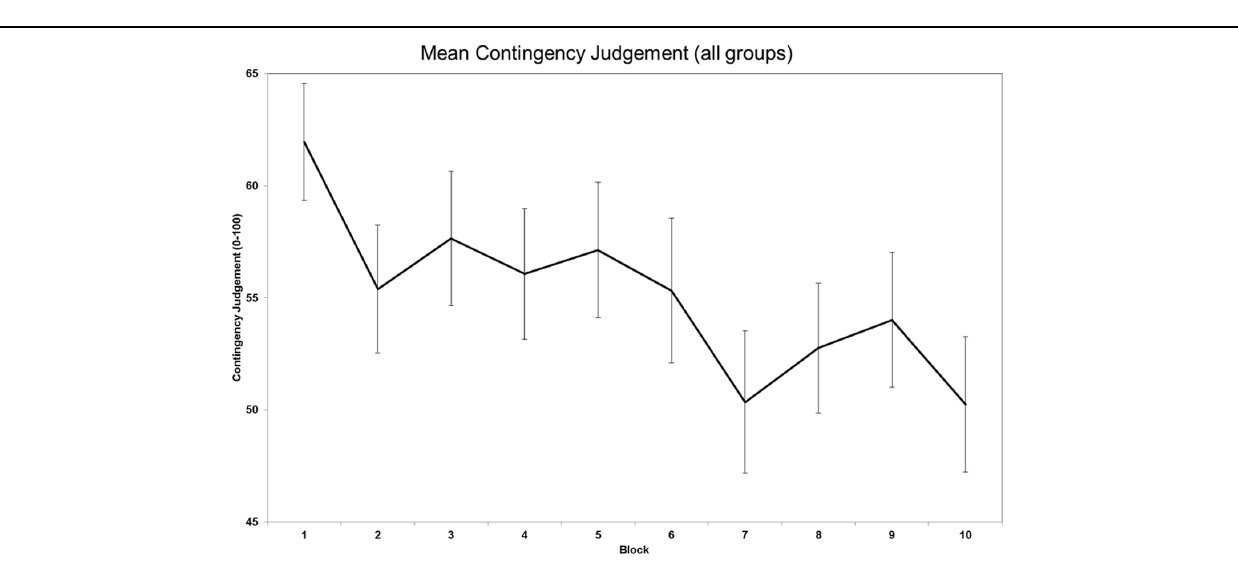
FIGURE 4 | Plot of mean contingency judgments across the 10 judgments participants